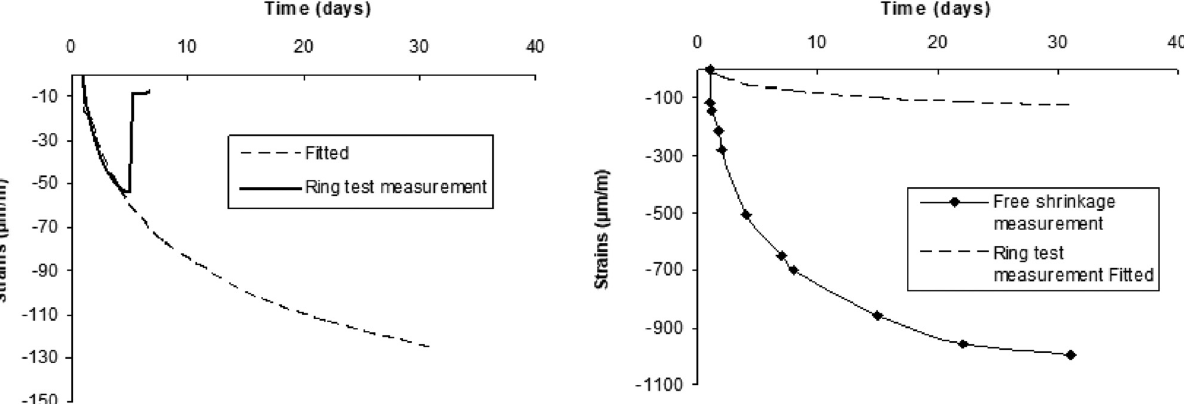
Figure 2: Variations in time of strains measured from ring specimens and 7 cm × 7 cm × 28 cm prismatic samples.